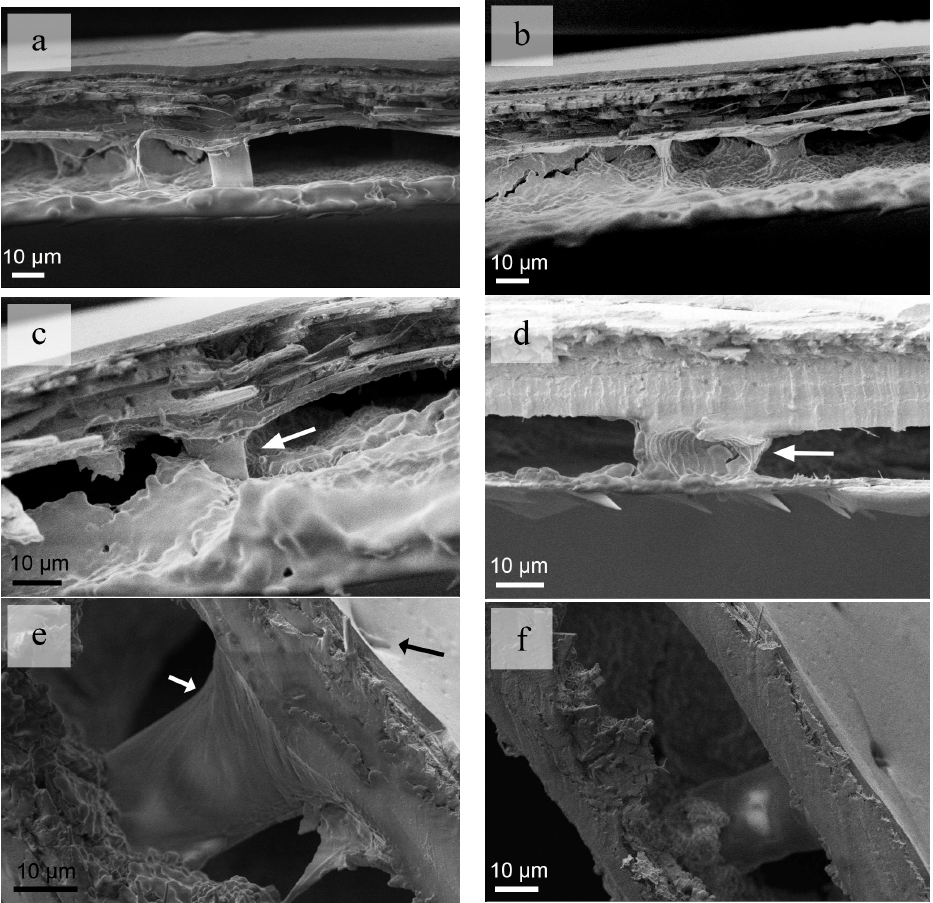
Figure 4. Honeycomb structures in the C. septempunctata L. elytra. ( a , b ) columns in the elytra; ( c ) column partially immedrsed in the foam; ( d ) internal structure of a column; ( e ) spiral surface of acolumn; ( f ) column and seta.